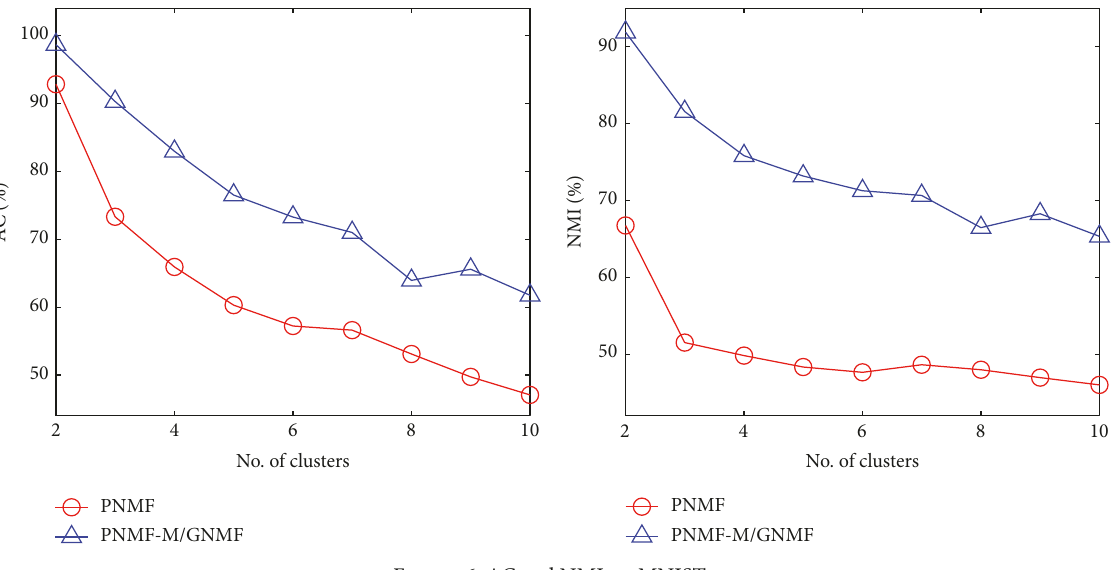
Figure 6: AC and NMI on MNIST.